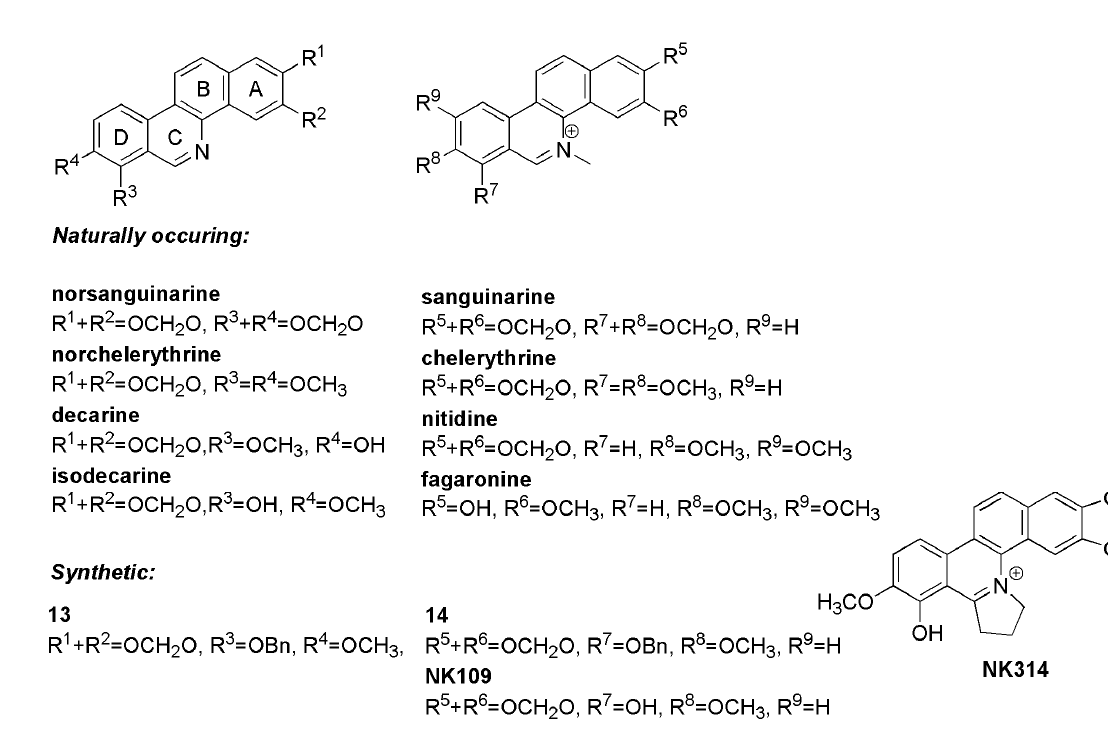
Figure 1. Structures of some benzo[ c